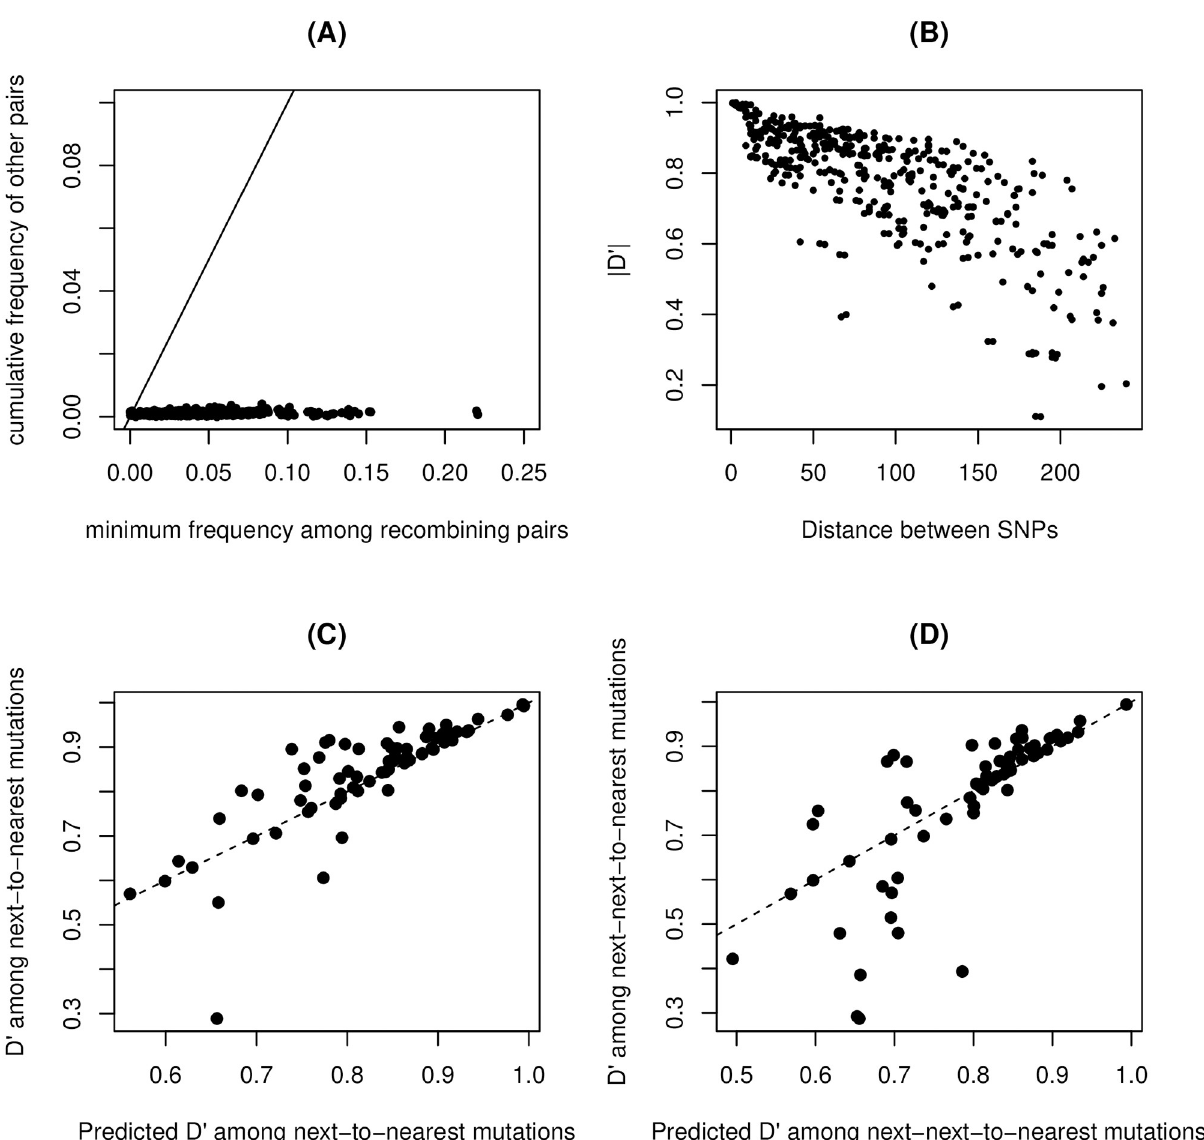
Fig 9. A: Frequency of the least frequent pair of recombinant alleles f r ,min versus the cumulative frequency f o of all other pairs. For example, if the two main alleles are (C,T) in the first site and (A,G) in the second, then the recombinants are CA, TG, CG, TA; if f CA = 0.5, f TG = 0.2, f CG = 0.1, f TA = 0.15, f CC = 0.03, f TC = 0.02, then f r ,min = 0.1 and f o = 0.05. Data points are shown for all pairs of polymorphic alleles of frequency > 0.25 covered by at least 10 4 reads. The black line corresponds to the case of equal frequency. B: Decay of LD measure | D 0 | with distance between SNVs. Data points are shown for all pairs of polymorphic alleles of frequency > 0.25 covered by at least 10 4 reads. C: D 0 among next-to-nearest SNVs versus the predicted value from ¼ D 0 . The dashed line corresponds to equality between predicted and estimated value. D: Same but for next-next-to-nearest SNVs. D 0 D 0 ik ij jk